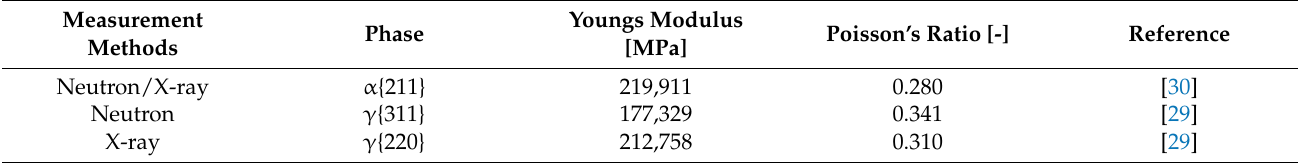
Table 3. Diffraction elastic constants (DEC) calculated on the basis of single crystal data according to the indicated references. The measurement methods indicate whether the DECs were used for evaluation of neutron and/or X-ray diffraction data.